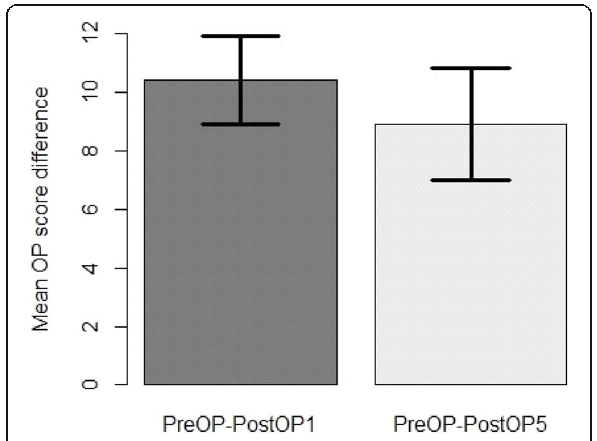
Fig. 1 Mean OKS difference 1 and 5 year(s) after operation